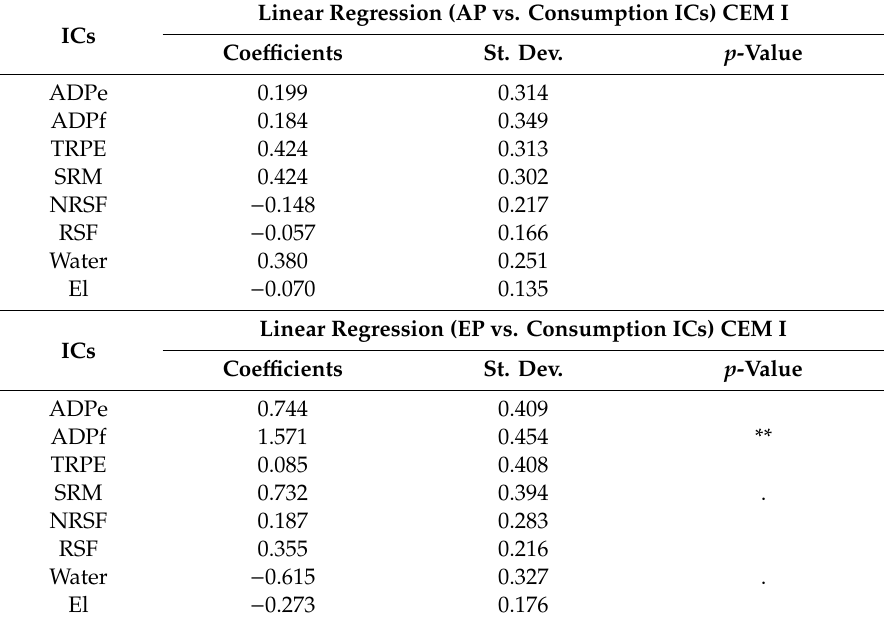
Table 16. Linear regression summary—CEM